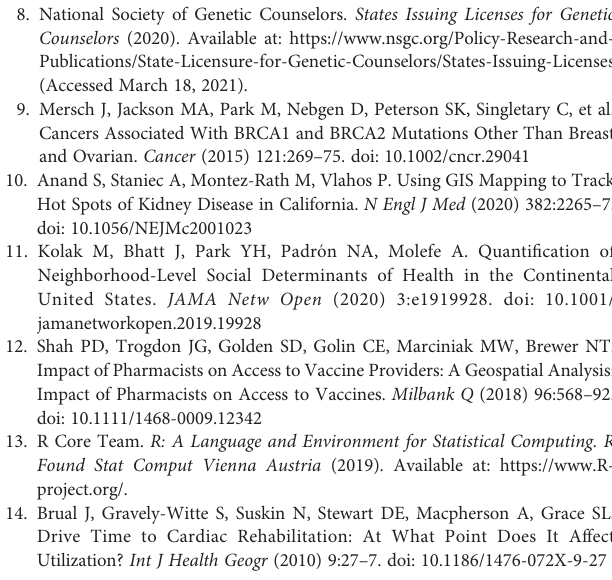
Supplementary Figure 1 | Provenance of genetic counselor data: Venn diagram of numbers of unique genetic counselors extracted from each source of provider information. Supplementary Figure 2 | Access to care by patients with BRCA -associated cancers by cancer type and U.S. region: box plots of access metric by combination of U.S. Census region and cancer type. Note that the state-level access to care (de fi ned as the median drive time for a cancer patient to a genetic counselor) is plotted on a log axis. Supplementary Figure 3 | Virtual genetic counselor access: histogram of state- level per-capita numbers of virtual counselors and measures of central tendency. Supplementary Figure 4 | State-level SDoH: probability densities of state-level SDoH distributions by mean-split per-capita virtual genetic counselor